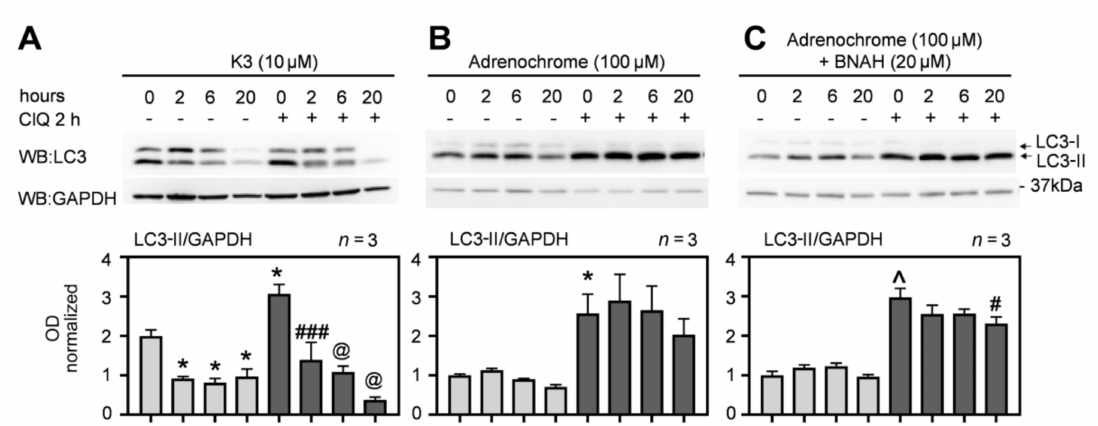
Figure 4. Suppression of basal autophagy by stimulation of NQO2 activity depends on its substrate. ( A ) HepG2 cells were exposed to menadione (K3), a known NQO2 substrate and treated or untreated with 25 µ M ClQ for 2 h before lysis, lysed at the same time and LC3-II was evaluated by WB (SDS-PAGE 12%). ( B , C ) Cells were treated with 100 µ M adrenochrome -/+ BNAH (20 µ M) for indicated times to stimulate cellular NQO2, then with 50 µ M ClQ 2 h before lysis and analyzed as above in A. The graphs below show the results of OD analysis from three independent experiments. Statistical analysis: one-way ANOVA followed by Bonferroni’s post-test. * p < 0.05, ∧ p < 0.0001 when compared to vehicle (0, -) or # p <